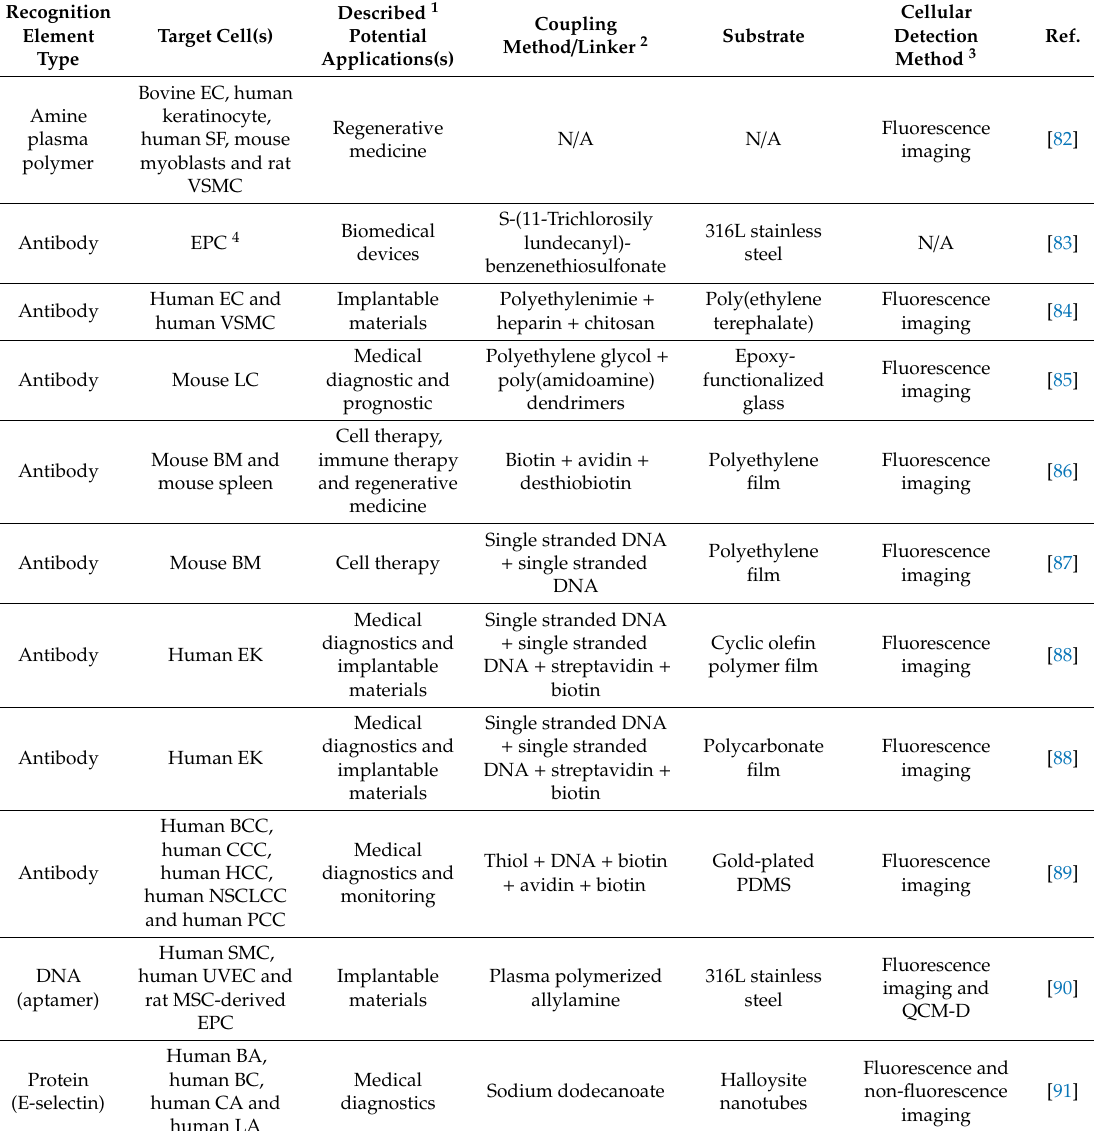
Table 3. Examples of cell type-specific biointerfaces used for cell